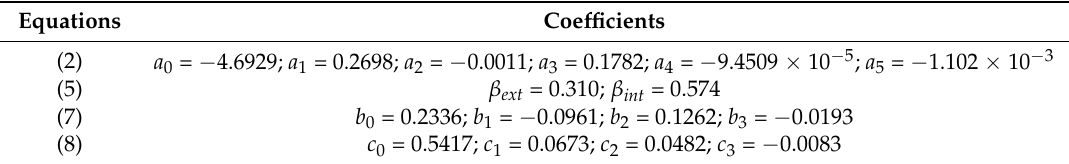
Table 3. Corresponding coefficients of the models and constraint.